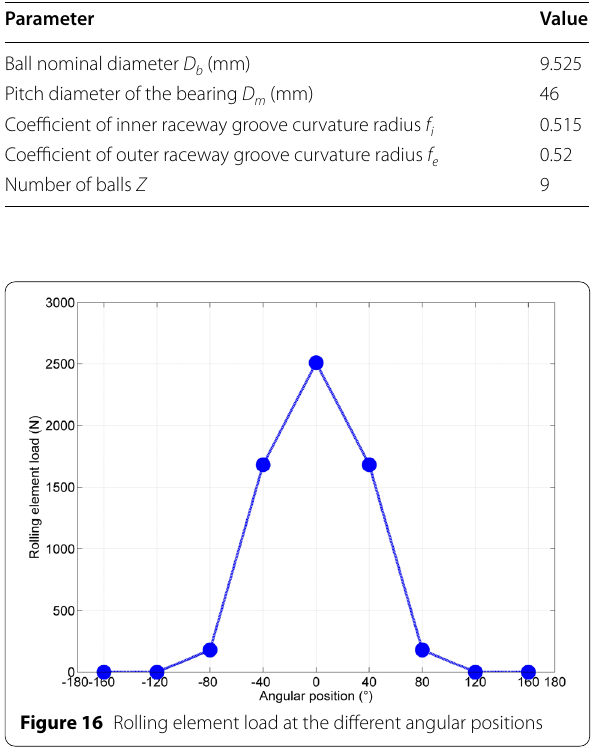
Figure 16 Rolling element load at the different angular positions